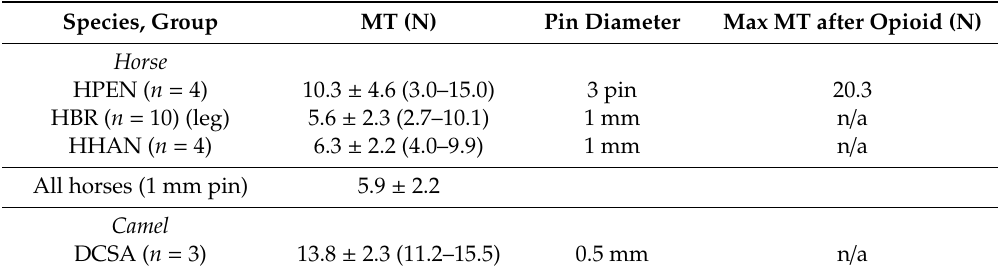
Table 3. Mechanical nociceptive thresholds (MTs) (mean ± SD and range) using a limb-mounted actuator under infra-red remote control during training in horses and